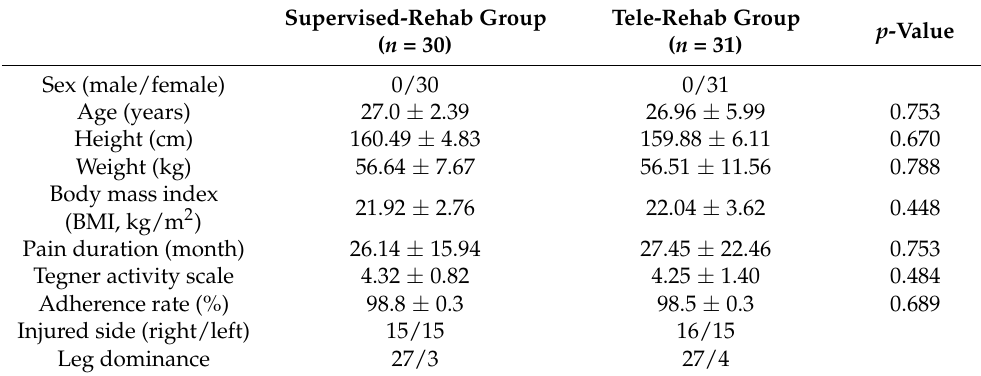
Table 1. Demographic data of participants in the supervised-rehab and tele-rehab groups.